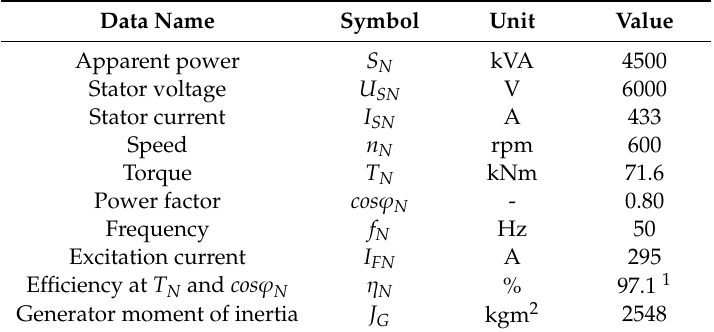
Table 1. Main rated data of investigated hydro